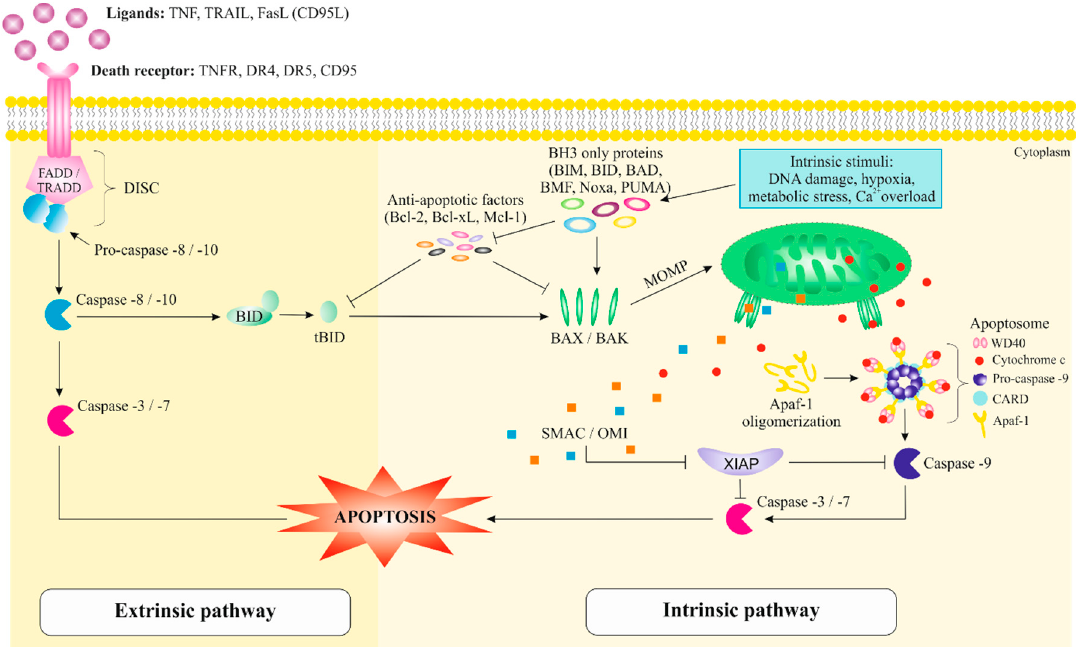
Figure 2. Molecular mechanism of extrinsic and intrinsic pathway involved in